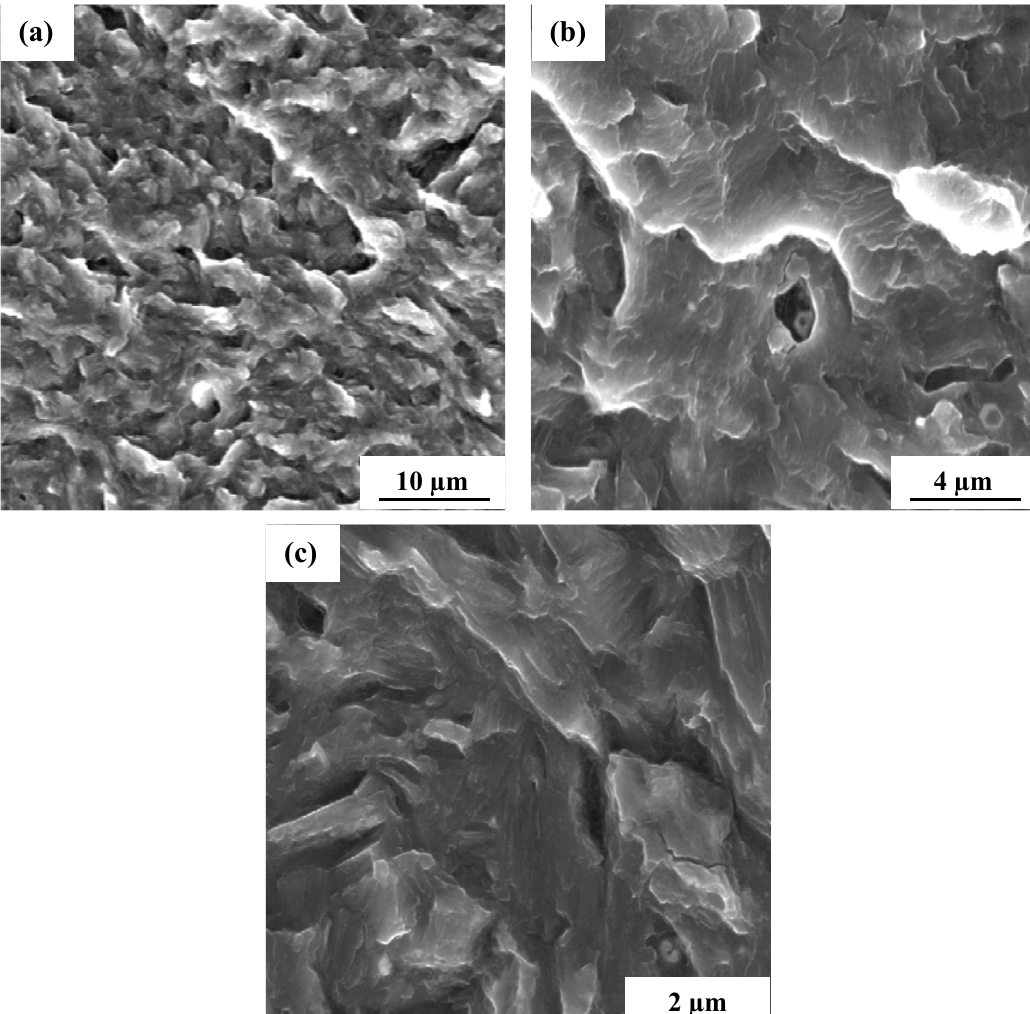
Figure 15. Scanning electron micrographs of the high cycle fatigue fracture surface of magnesium alloy AZ31 cyclically deformed at maximum stress of 101.82 MPa, at load ratio of − 1. And resultant fatigue life of 240,921 cycles, showing: ( a ) Intrinsic features in the region of early microscopic crack growth; ( b ) Microscopic voids and microscopic cracks observed in the region of stable crack growth and ( c ) High magnification observation of the region of stable crack growth prior to the onset of unstable crack growth revealing fine microscopic cracks and shallow nature of